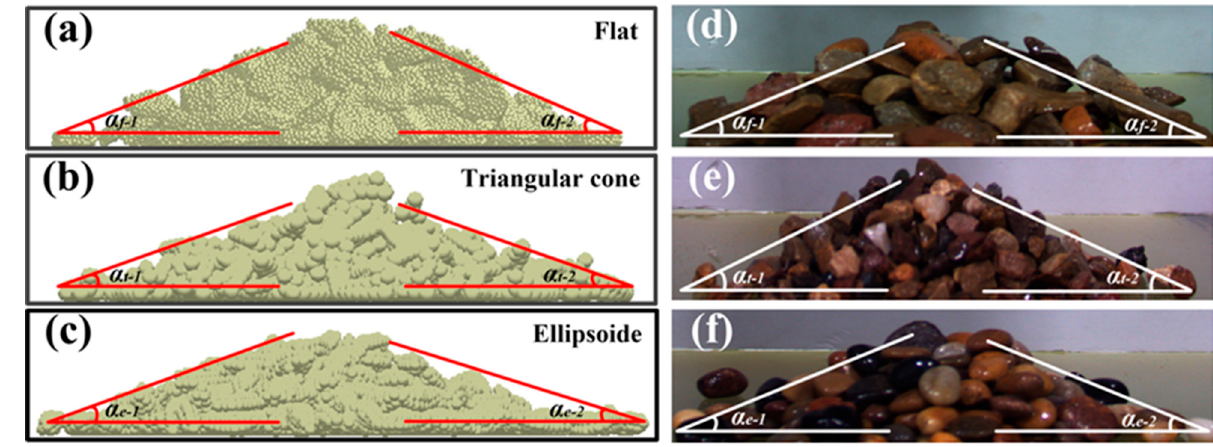
Figure 4. Simulation ( a – c ) and experiment ( d – f ) for cylinder lifting. Table 1. Significant factors influencing the contact parameters of wet sand and gravel.